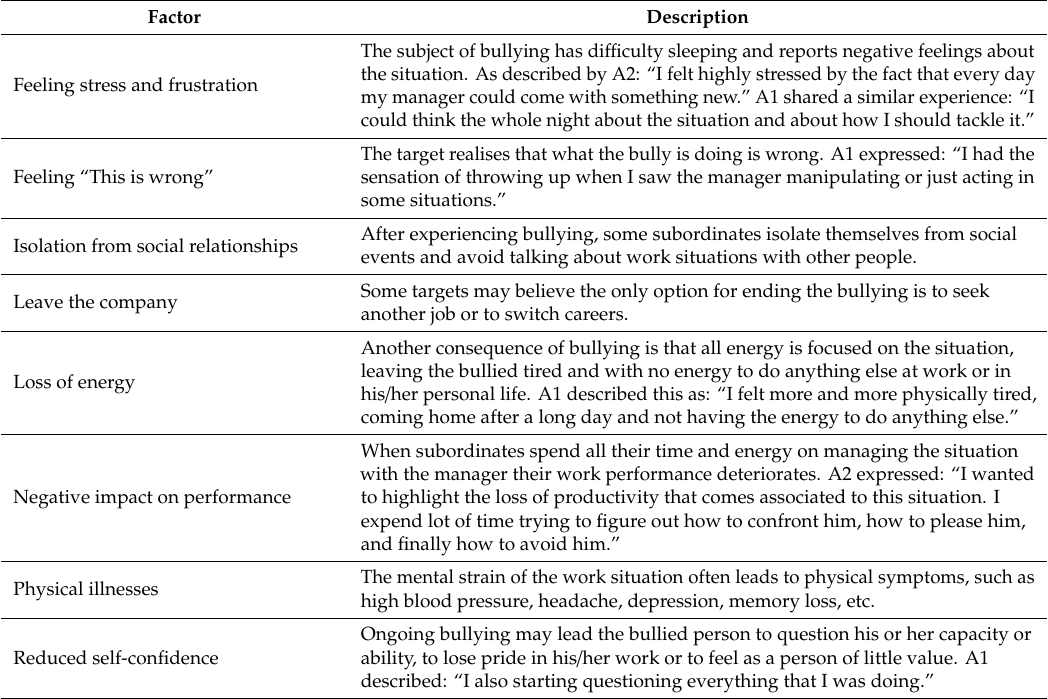
Table 4. Consequences of vertical